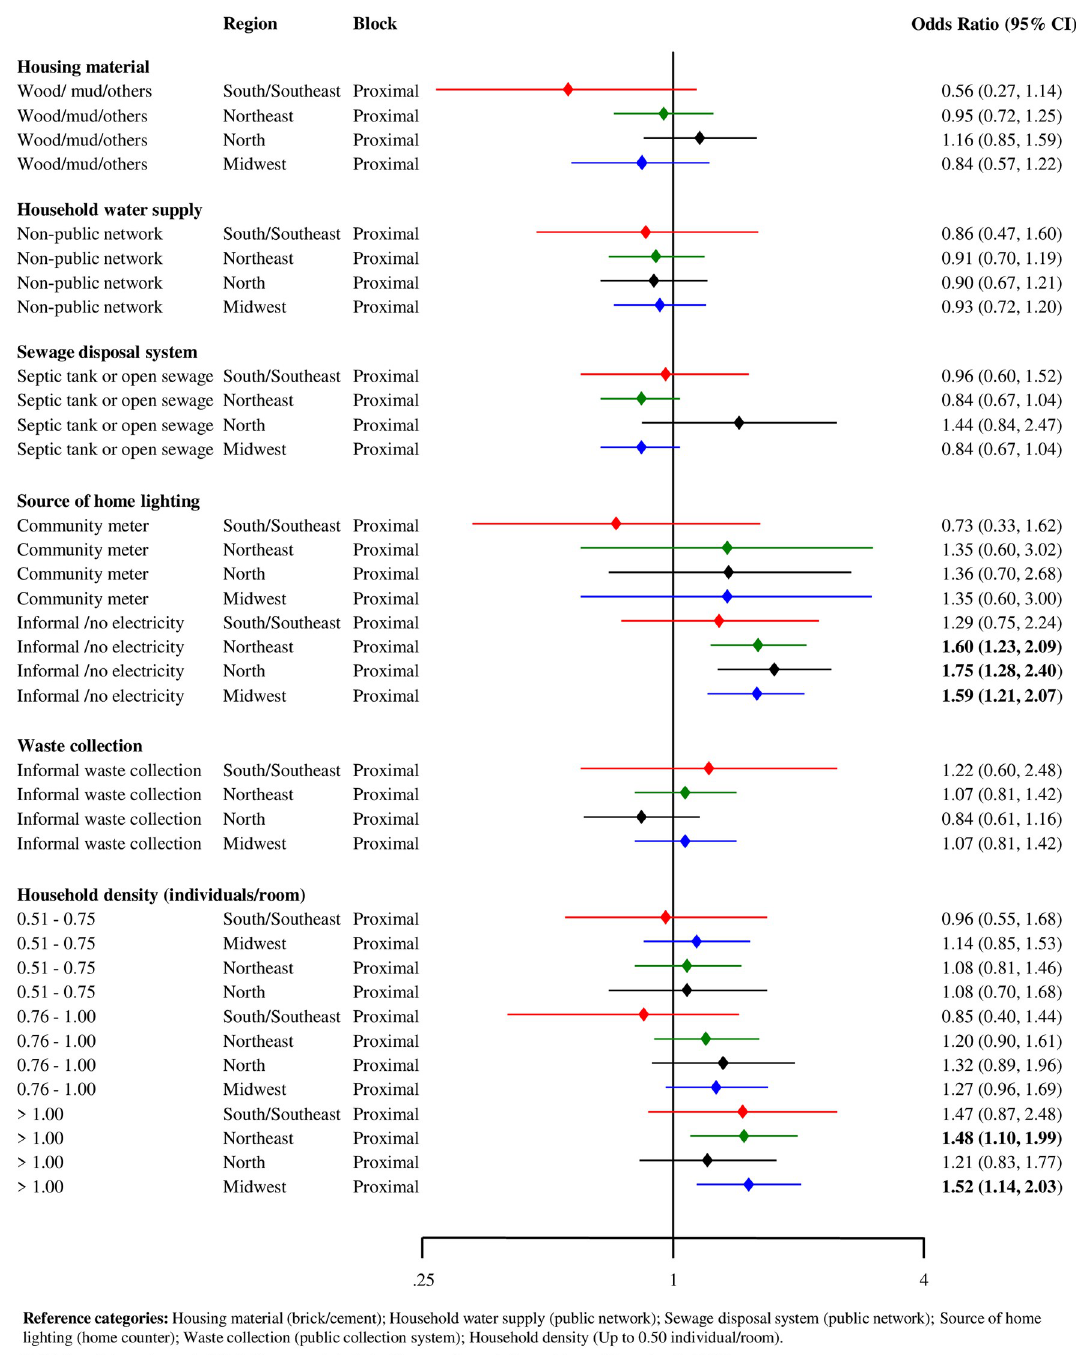
Fig 6. Forest plot of hierarchical association of proximal factors with leprosy treatment default (N = 20,063), stratified by Brazilian regions, Brazil, 2007–2014.